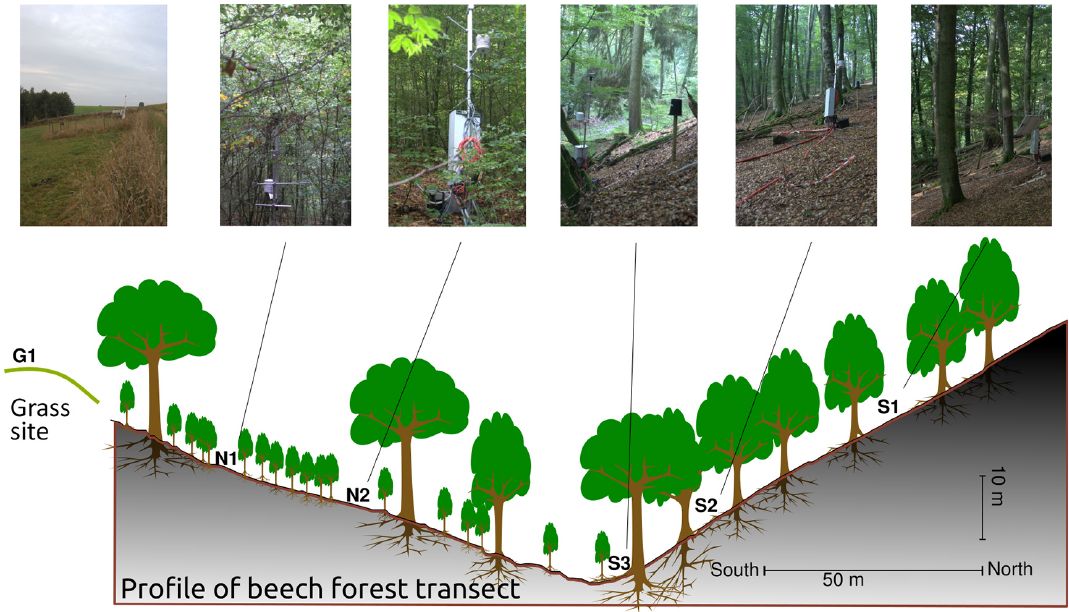
Figure 1. Measurement setup along a hillslope transect. Captital letters indicate aspect of the sites (N: north-facing, S: south-facing) and the numbering represents the position of the site on the hillslope: upslope (1), midslope (2), and downslope (3).